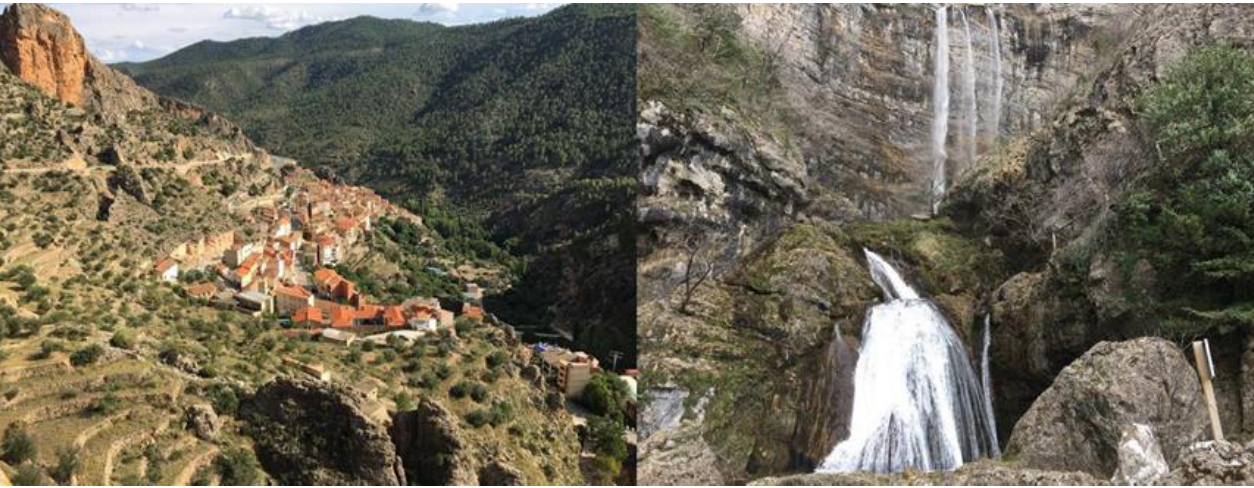
Figure 7. Components of the rural landscape in the study area (abandoned cultivation terraces in Ayna and the source of the River Mundo in Riópar). Source: Own preparation.